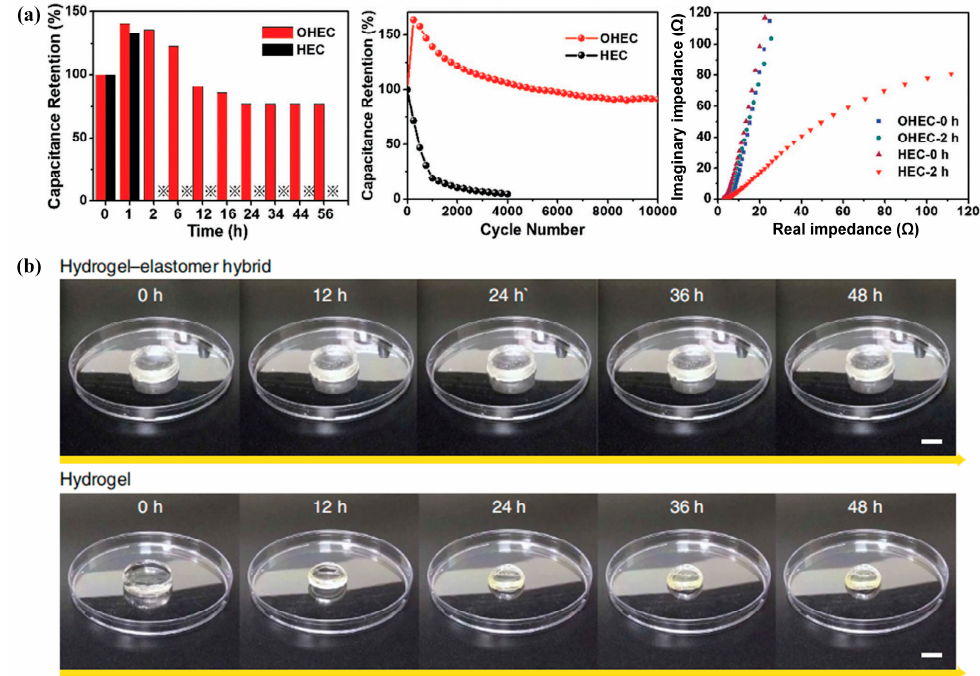
Figure 5. Anti-drying properties of hydrogels: ( a ) Electrochemical property of OHE supercapacitor at 80 °C; ( b ) Comparison of hydrogel-elastomer hybrid and hydrogel during the dehydration. Reprinted with permission from [58,62].